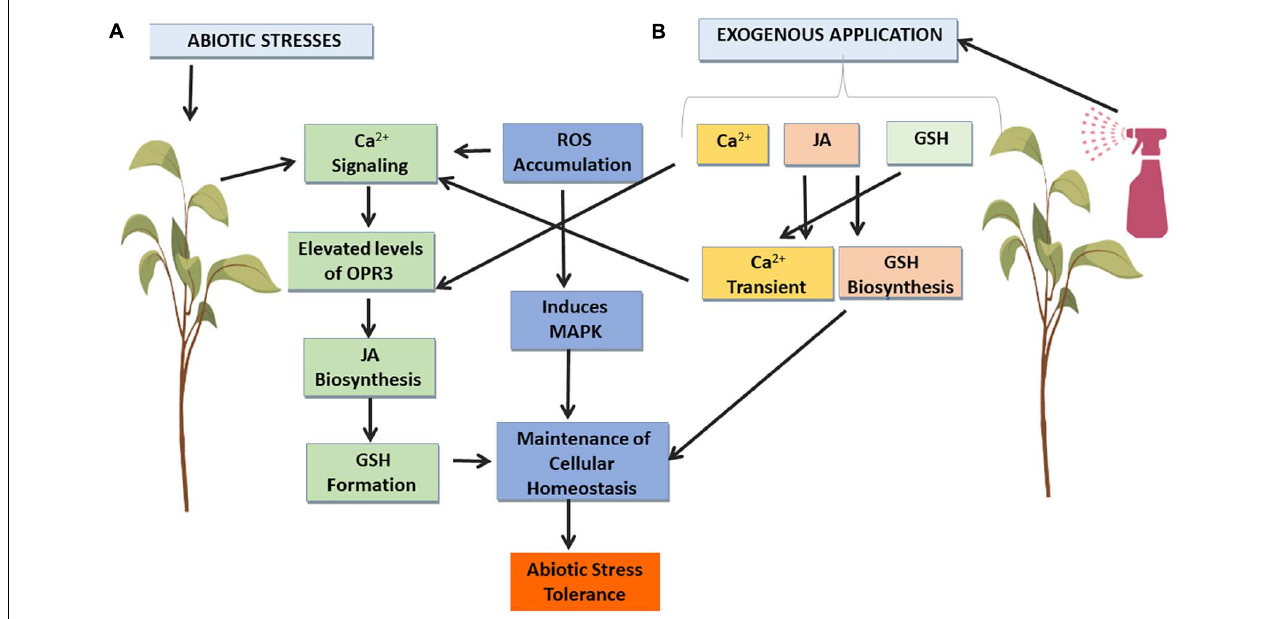
FIGURE 3 | Signaling pathways involved in abiotic stress tolerance. (A) Abiotic stresses causes ROS accumulation that leads to activation of Ca 2 + signaling and MAPK pathways to combat abiotic stresses in plants by maintaining cellular homeostasis. (B) Exogenous application of JA, Ca 2 + and GSH, respectively, to plants prior to or under abiotic stress mediates activation of Ca 2 + signaling and MAPK pathways via possible crosstalk mechanisms so as to further strengthen the cellular homeostatic mechanisms of plants, thereby imparting abiotic stress tolerance.